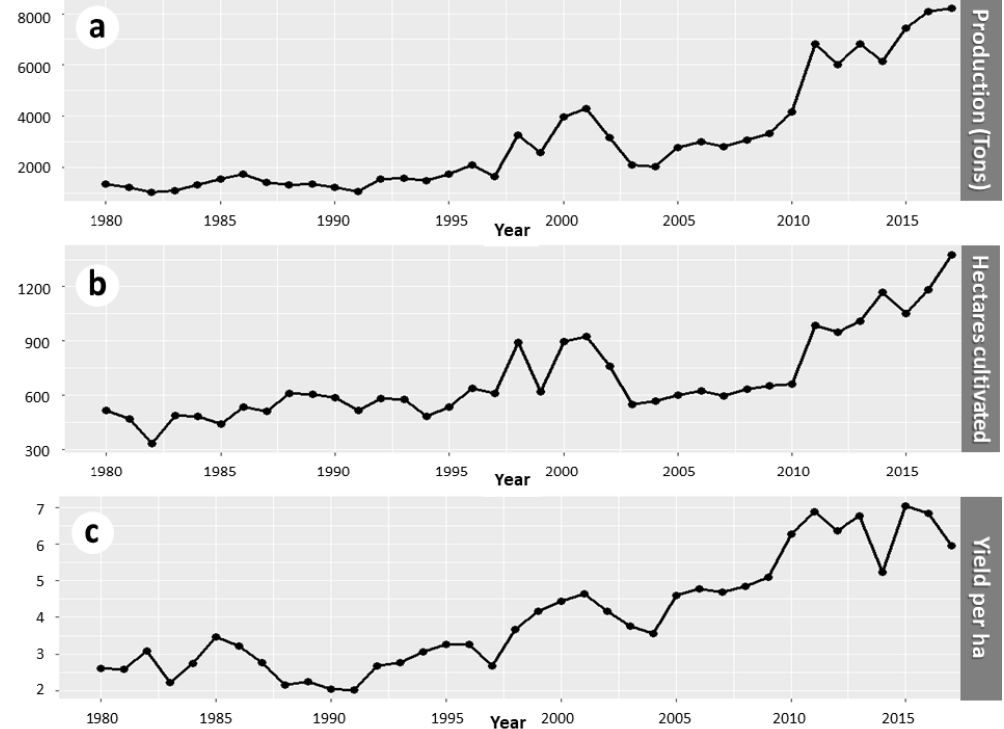
Figure 2. Representation of production in Mexico from 1980 to 2017. ( a ) Production in tons. ( b ) Area cultivated in hectares. ( c ) Corresponding yield per hectare.